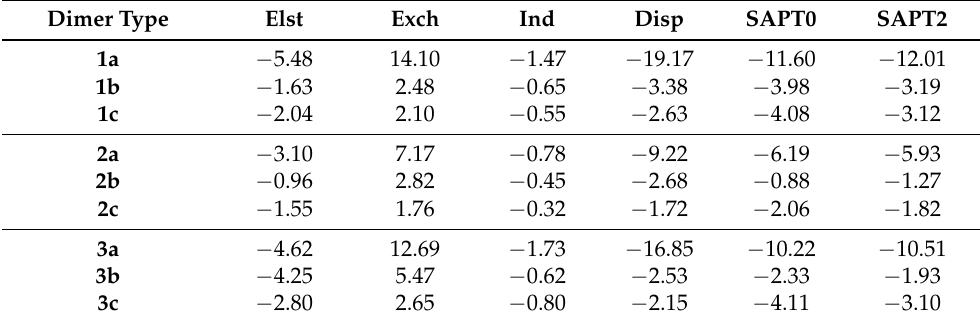
Table 4. The results of the SAPT energy partitioning at the SAPT2 level for the dimers of compounds 1 , 2 and 3 depicted in Figure 6. Structures are taken from the crystal X-ray data available [20–22]. All energy terms in kcal/mol: Elst—electrostatics; Exch—exchange (Pauli) repulsion; Ind—induction (polarization); Disp—dispersion; SAPT0 and SAPT2 are defined according to Ref. [35]. Dimer